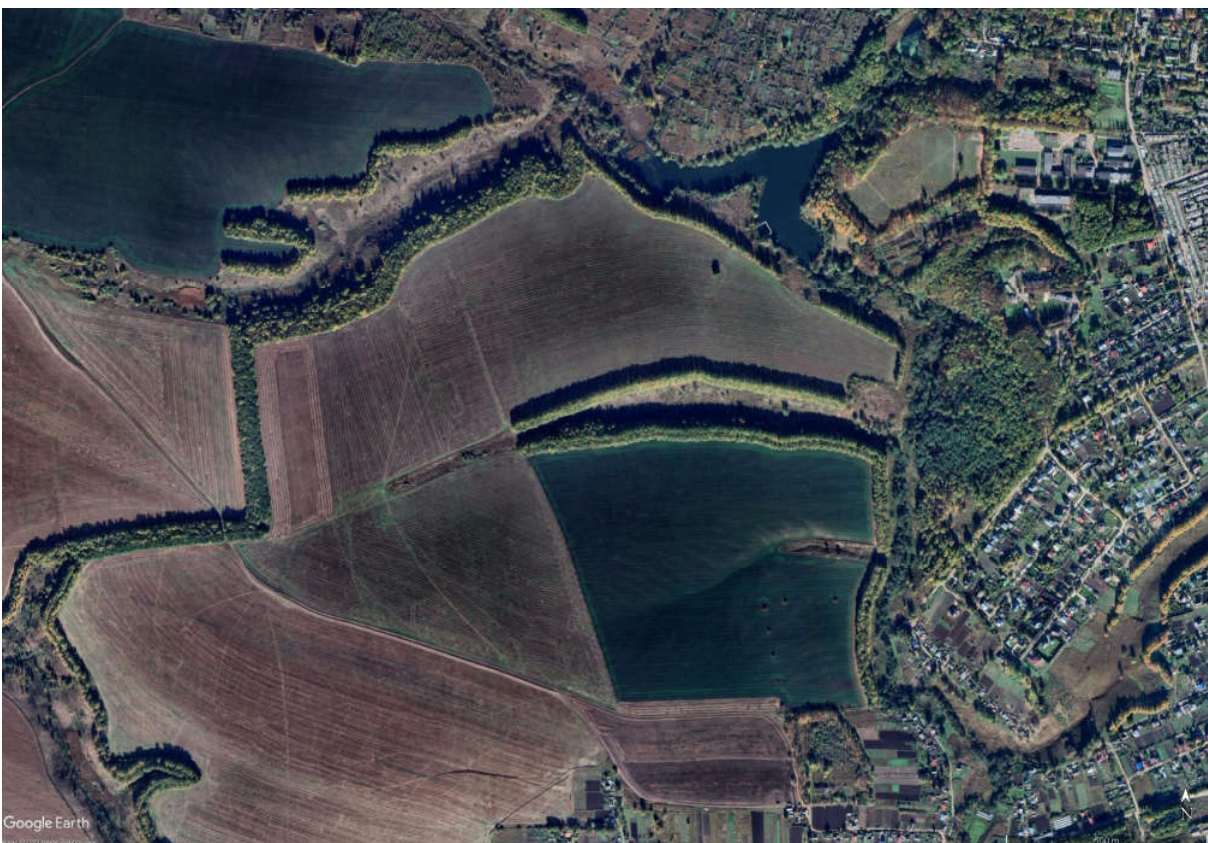
Figure 2 . Experimental area in the basin of the Sukhaya Orlitsa River (Oryol region). Satellite image courtesy of Google Earth.